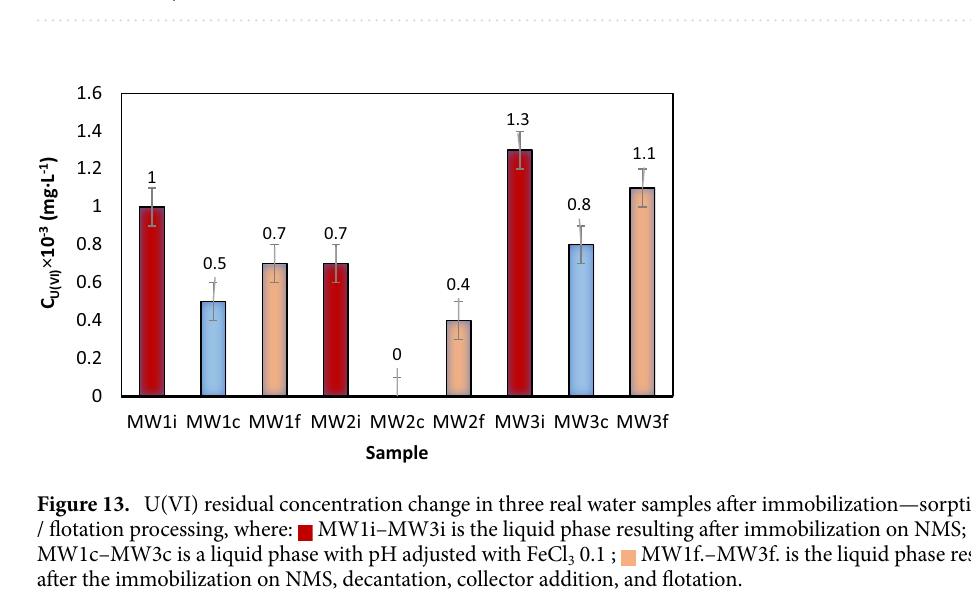
Figure 12. The separation scheme for the treatment of a multi-component system by sorption flotation adapted to the studied system 51 .